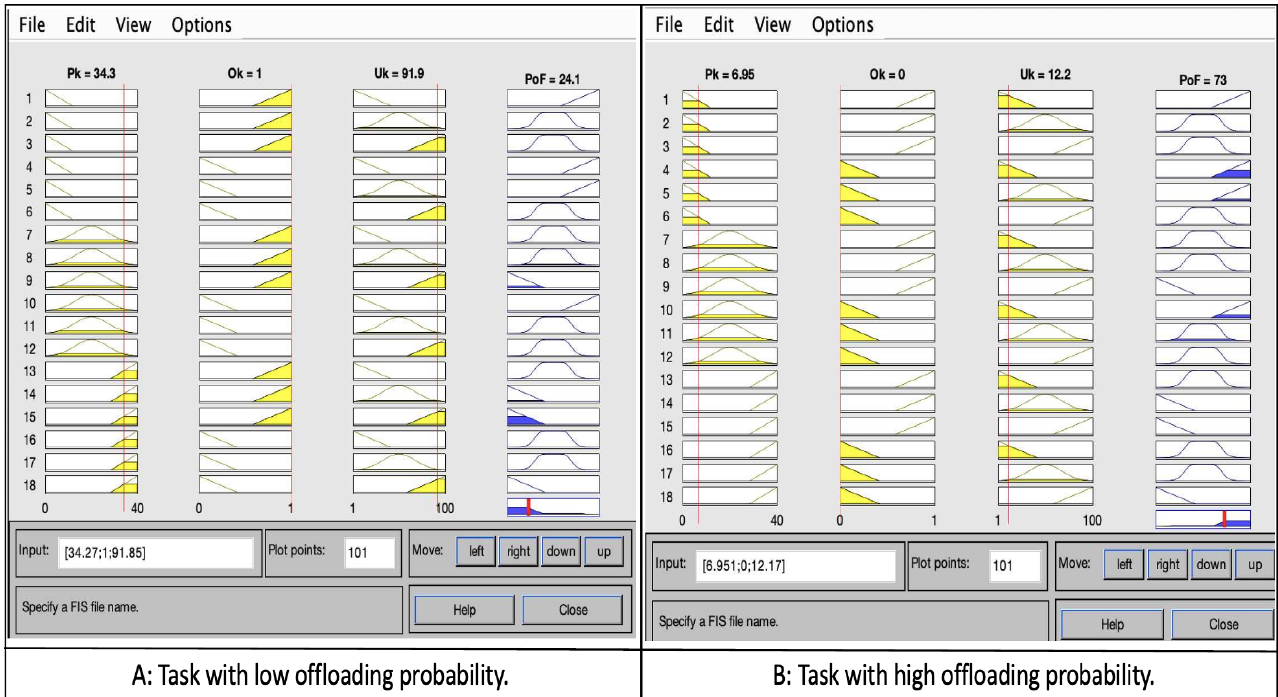
Figure 5. The effect of ( p k , o k , u K ) on the probability of offloading ( r k ).